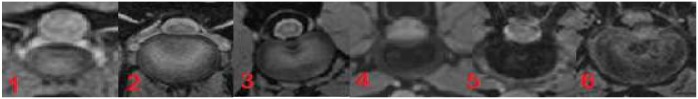
Grading system for T1W FFE-sequence (designed by KK and AT). Grade 1 and 2 included healthy intervertebral discs in dogs younger (grade 1) or older than 12 months (grade 2). The disc displays a homogeneous structure and a signal intensity isointense to adjacent muscles (Mm trunci). Grade 3 is characterized by mild degeneration affecting at the maximum one-third of the intervertebral disc with a hypointense nucleus pulposus. Moderate degeneration (grade 4) affected at the minimum one-third and at the maximum two-third of the intervertebral disc (hypointense to surrounding tissue). In high grade degeneration (grade 5) more than two-third of the intervertebral disc is affected and hypointense to the surrounding tissue. Disc herniations are displayed under “6”.